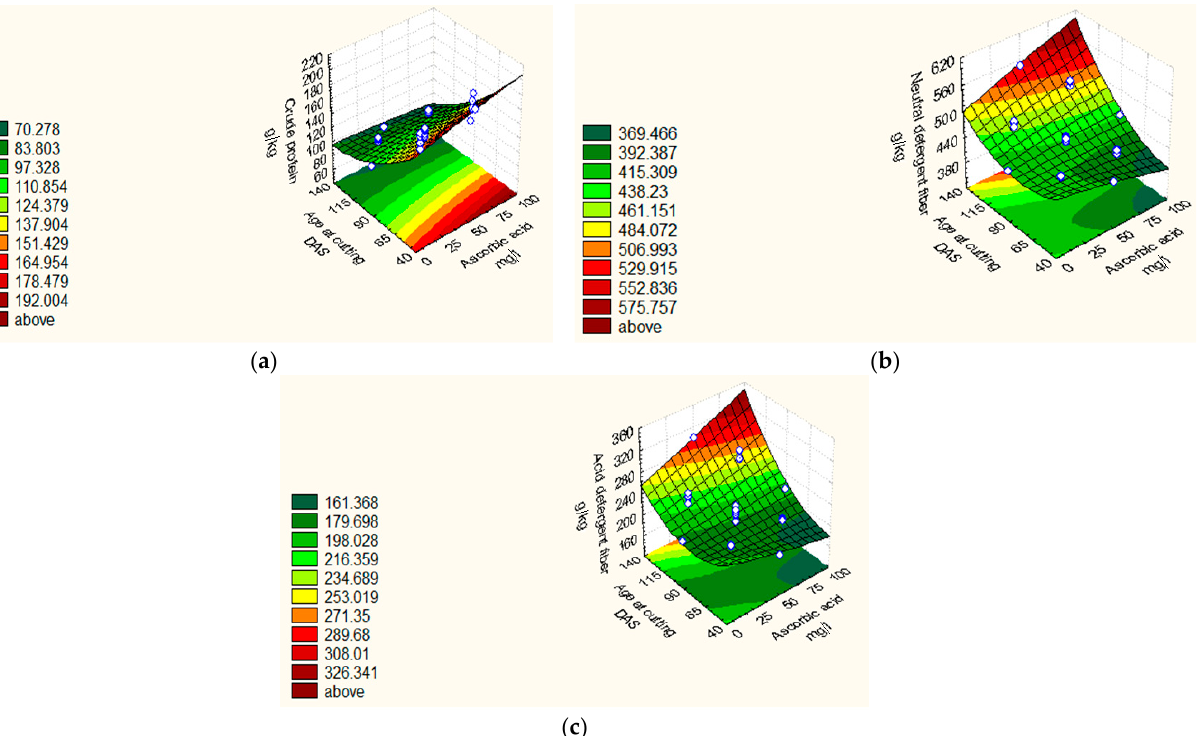
Figure 3. Response surface for crude protein ( a ), neutral detergent fiber ( b ) and acid detergent fiber ( c ) as affected by AA and AC at the central levels of PF and HA in 2018/19.